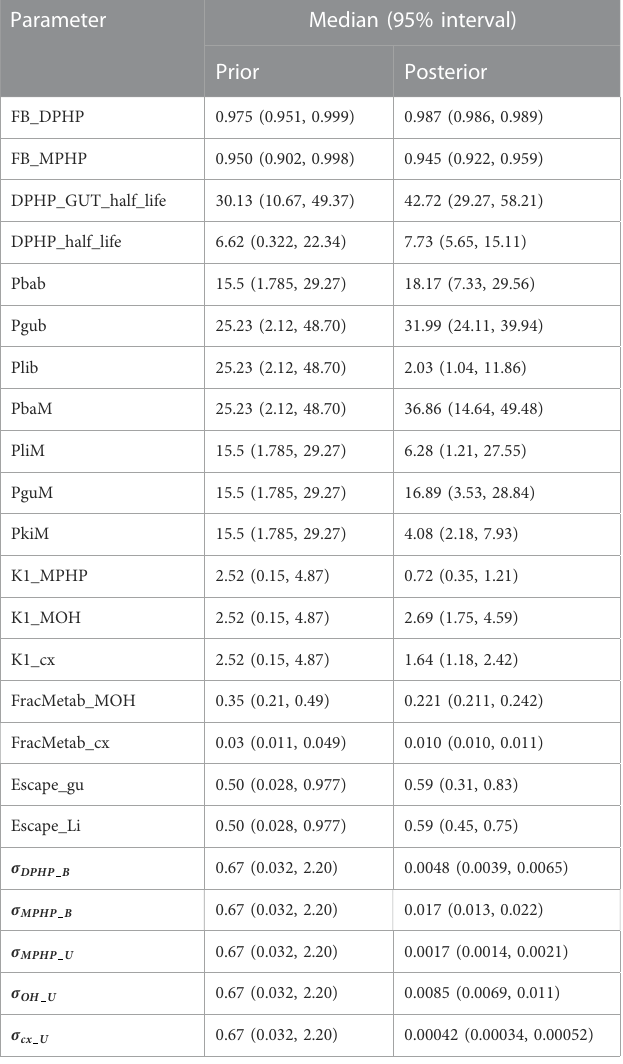
TABLE 4 Global prior and posterior pdarameter distributions.